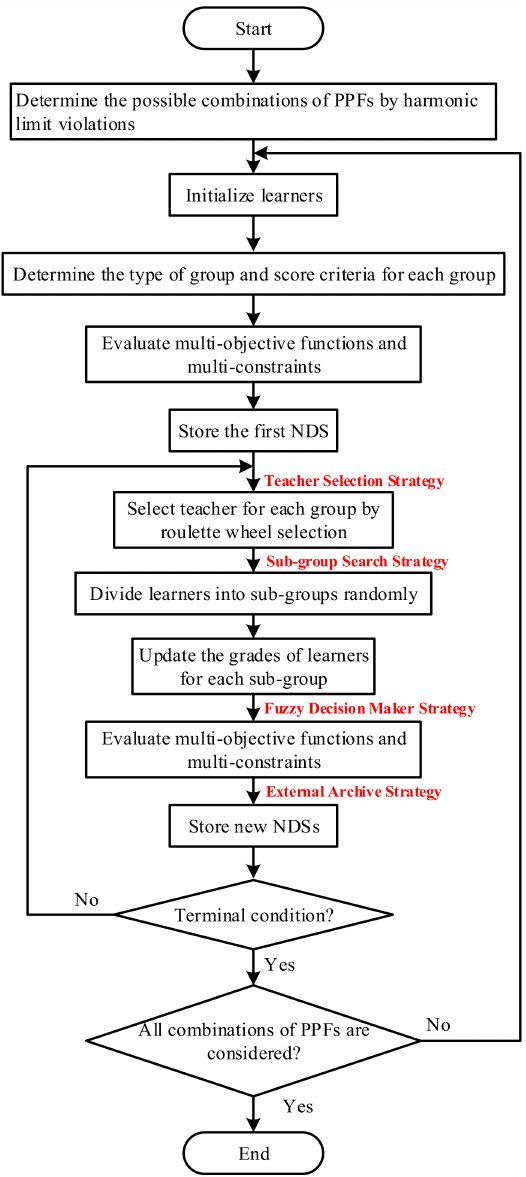
Figure 5. Flowchart of the proposed multi-objective TLBO